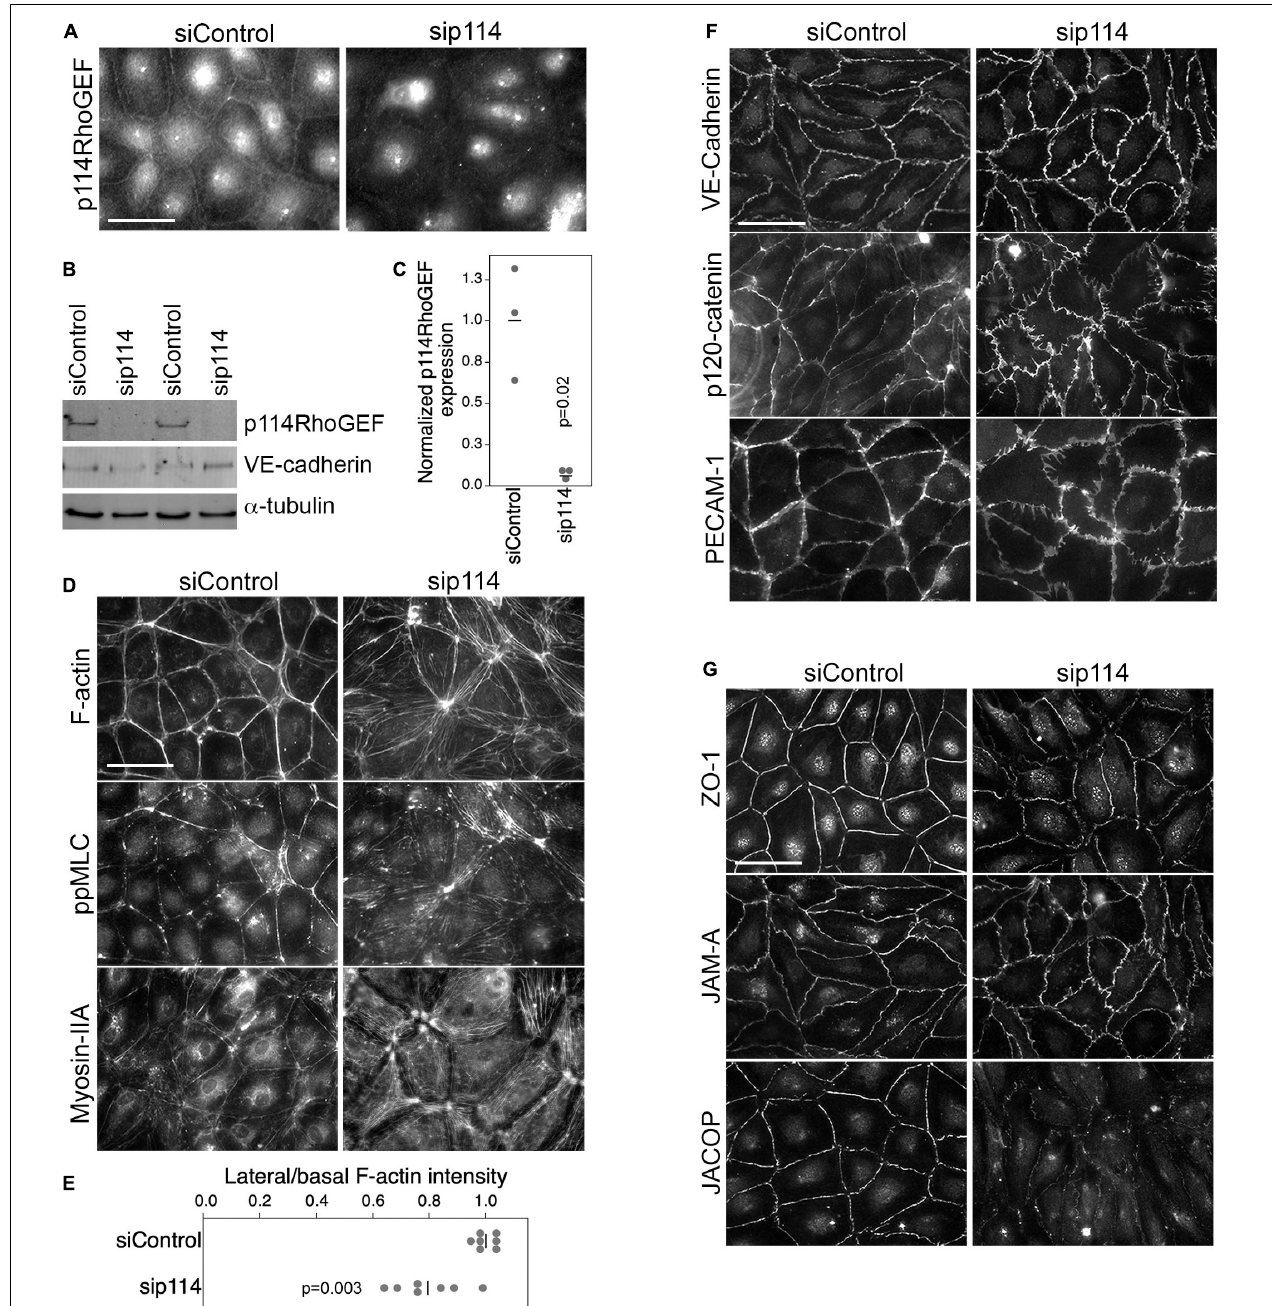
FIGURE 3 | p114RhoGEF depletion in endothelial cells leads to rearrangement of the actin cytoskeleton. HDMECs were transfected with control or p114RhoGEF-targetig siRNAs prior to analysis by immunofluorescence (A,D,F,G) or immunoblotting (B) using antibodies against (A) 114RhoGEF; (D) double phosphorylated myosin regulatory light chain (ppMLC) and Myosin-IIA heavy chain; (F) the adherens junction proteins VE-Cadherin, p120-catenin, and PECAM-1; and (G) the tight junction proteins ZO-1, JAM-A, and JACOP. Fluorescently labeled phalloidin was used to label F-actin. Expression of p114RhoGEF was quantified and calculated as a ration to α -tubulin expression (C) . Redistribution of F-actin was quantified by calculating ratios of lateral vs. basal F-actin intensity (E) . Quantifications are based on three independent experiments and p -values were calculated with t -tests. Bars: 40 µ m.